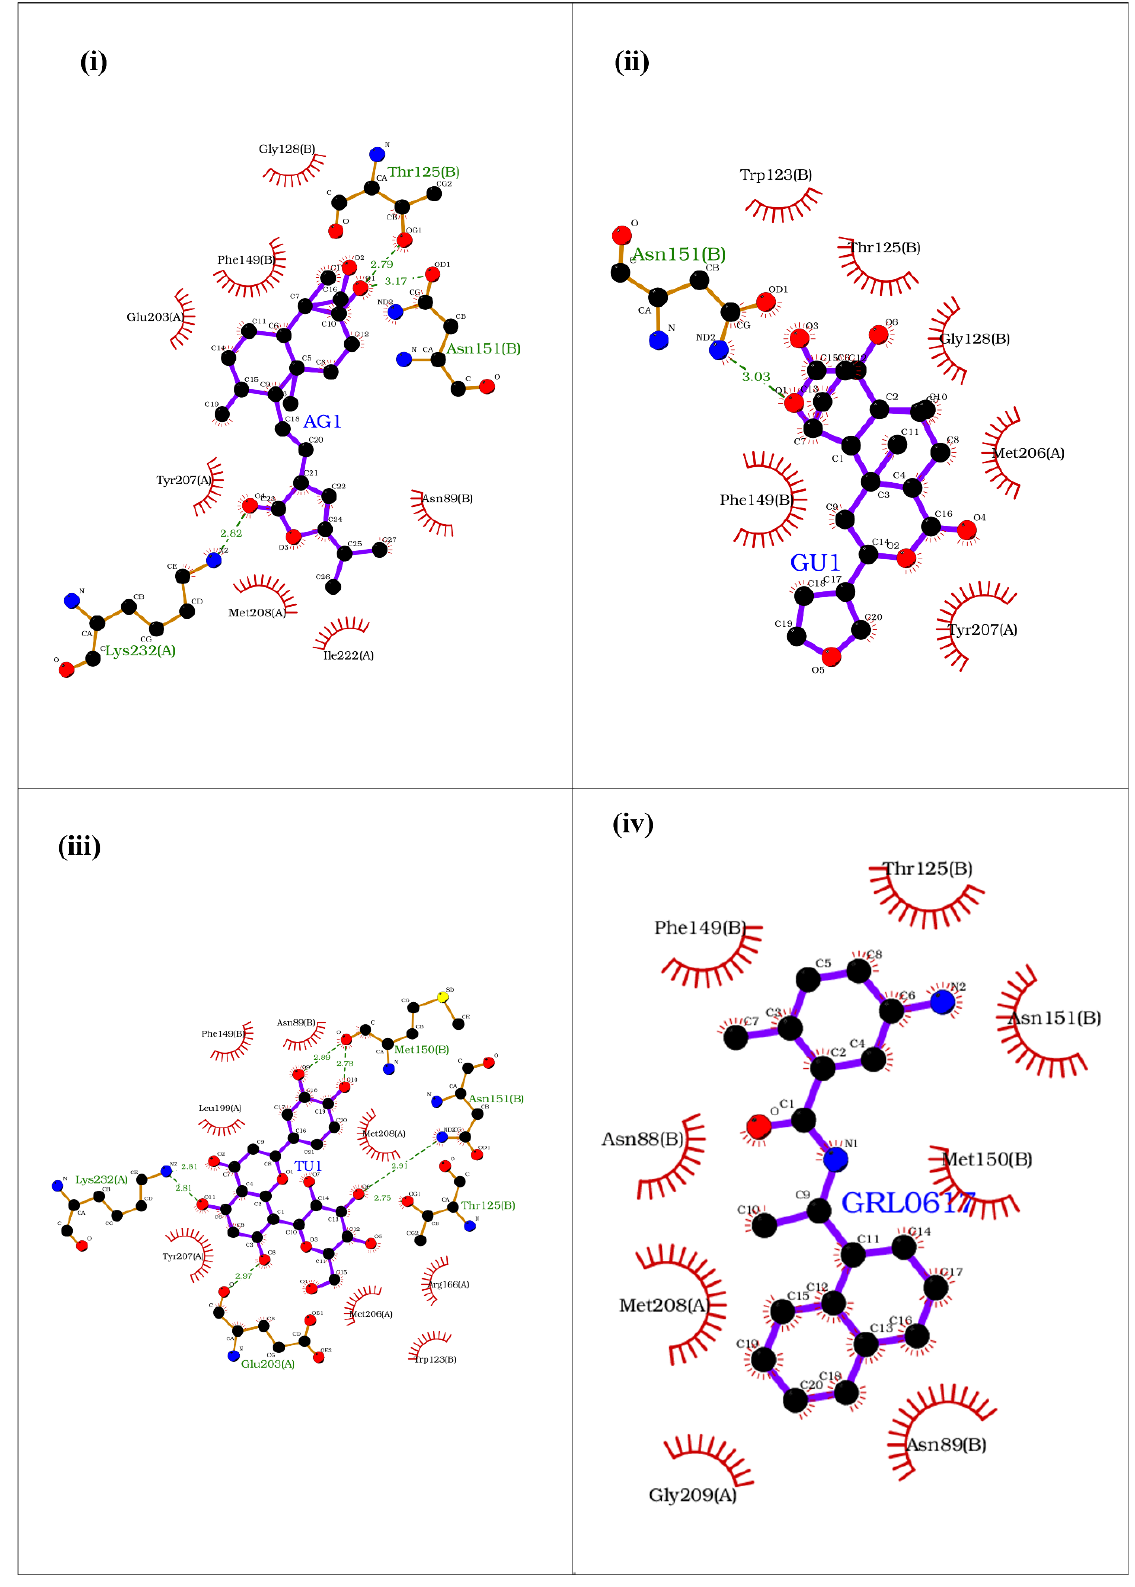
Figure 1. Binding of ( i ) AU1 (14-deoxy-15-isopropylidene-11,12-didehydroandrographolide), ( ii ) GU1 (Isocolumbin), ( iii ) TU1 (Orientin), and ( iv ) GRL0617 at the ISG15 interacting site of UIM domain of PLpro of SARS-CoV-2.